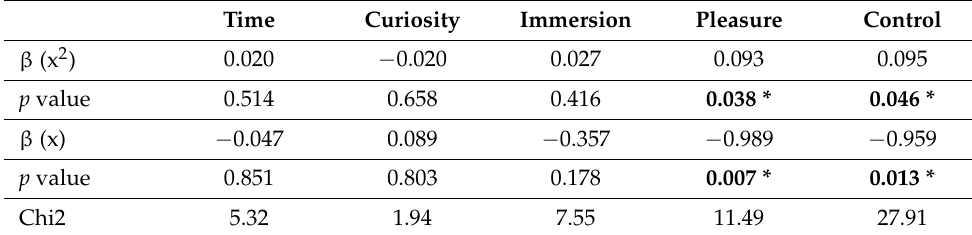
Table 7. Quadratic effect of perceived cognitive effort on each CA dimension.